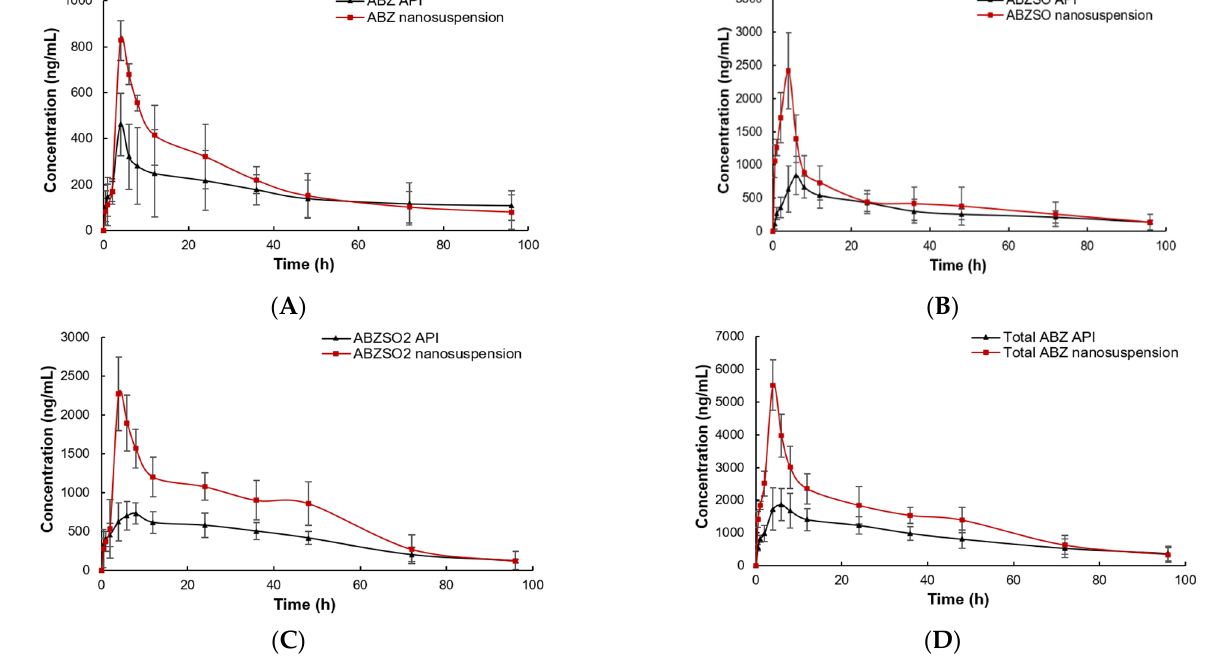
Figure 10. The concentration vs. time curves of ABZ ( A ), ABZSO ( B ), ABZSO 2 ( C ) and total active ingredient ( D ) in SD rats after oral administration of nanocrystals and native ABZ at a dose of 100 mg/kg body weight. Table 3. Pharmacokinetic parameters of native ABZ and nanocrystals in SD rats after an oral dose of 100 mg/kg (mean ± standard deviation, n = 6).